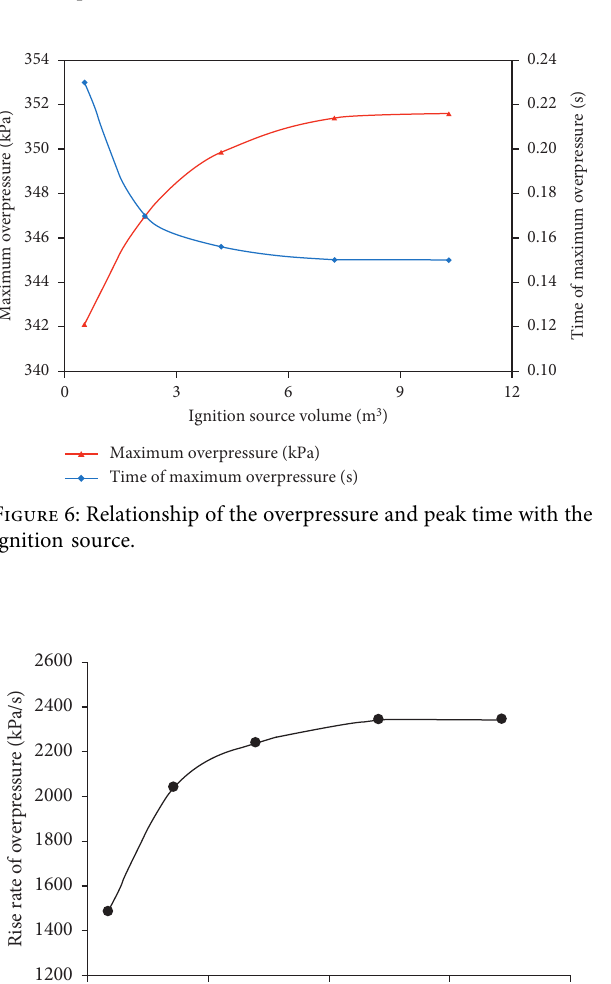
Figure 5: The maximum overpressure and its occurrence time at different